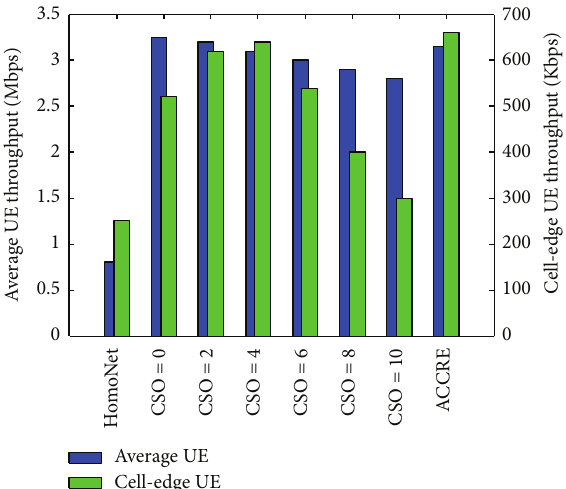
Figure 9: Cell-edge and average UE throughputs versus ICIC ( 𝛼 ) in hotspot UE distribution [9].